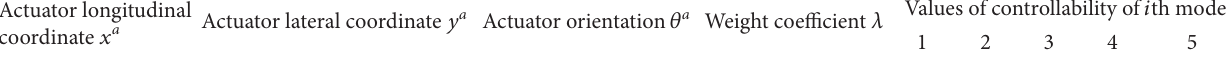
Table 6: The effect of values of the weight coefficients on the controllability for a single actuator for the case that only the second mode is controlled.